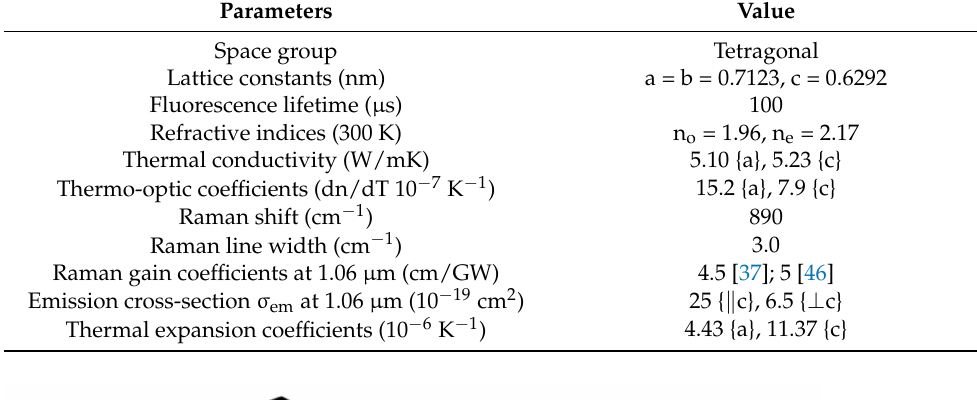
Table 1. The property parameters of the Nd:YVO 4 crystal [26].